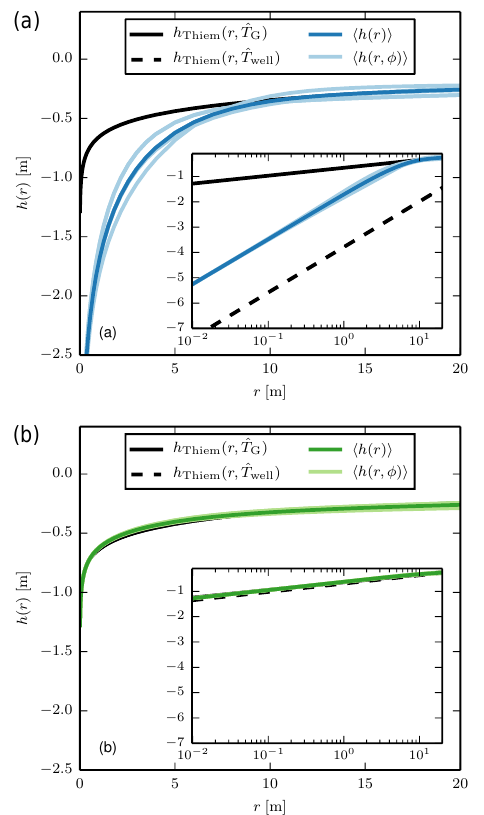
Figure 3. Drawdowns simulated for two individual transmissiv- ity field realizations of ensemble A ( T G = 10 − 4 m 2 s − 1 , σ 2 = 1, (cid:96) = 10m): (a) realization with T well = 0 . 204 × 10 − 4 m 2 s − 1 and (b) realization with T well = 1 . 11 × 10 − 4 m 2 s − 1 . (cid:104) h(r) (cid:105) (dark color) is the radial mean, (cid:104) h(r,φ) (cid:105) (light color) denotes the drawdowns along the four axes ( φ = 0 ◦ , 90 ◦ , 180 ◦ , 270 ◦ ), and in black is Thiem’s solution for constant values.